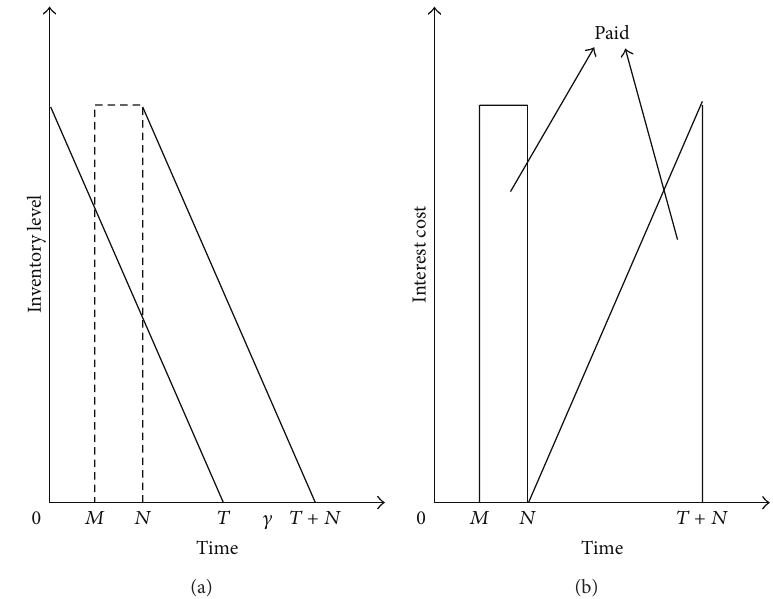
Figure 3: Inventory system for Case 1 when 𝑇 ≤ 𝛾 .